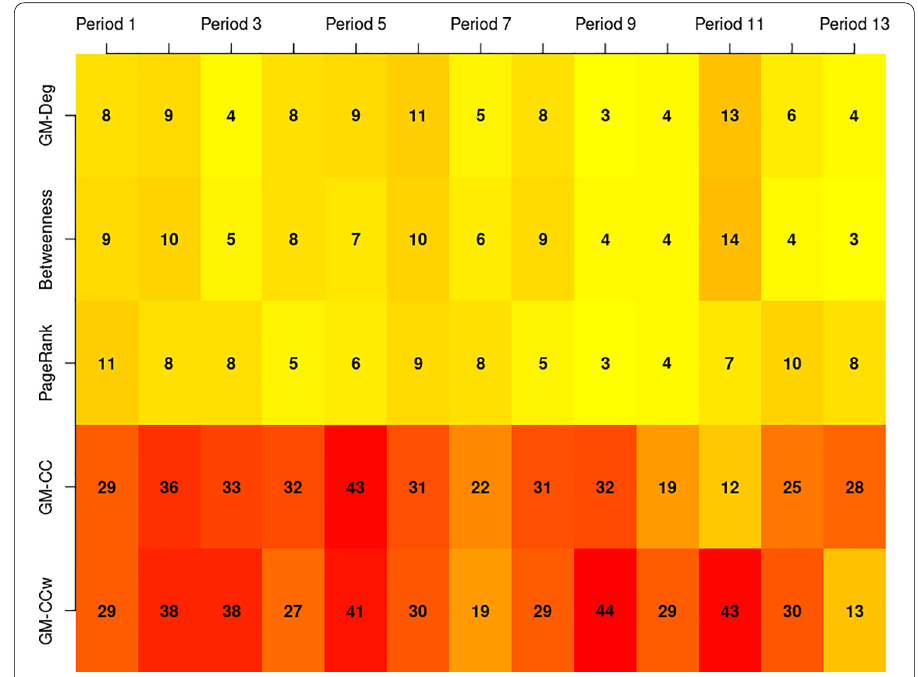
Fig. 10 Matrix comparing the network analyses and simulations results per 4‑week period. Percentage of most risky farms according to the simulations, correctly identified as such by the different network measures. CC : geometric mean unweighted contact chain; GM GM Deg : geometric mean degree; GM − − geometric mean weighted contact